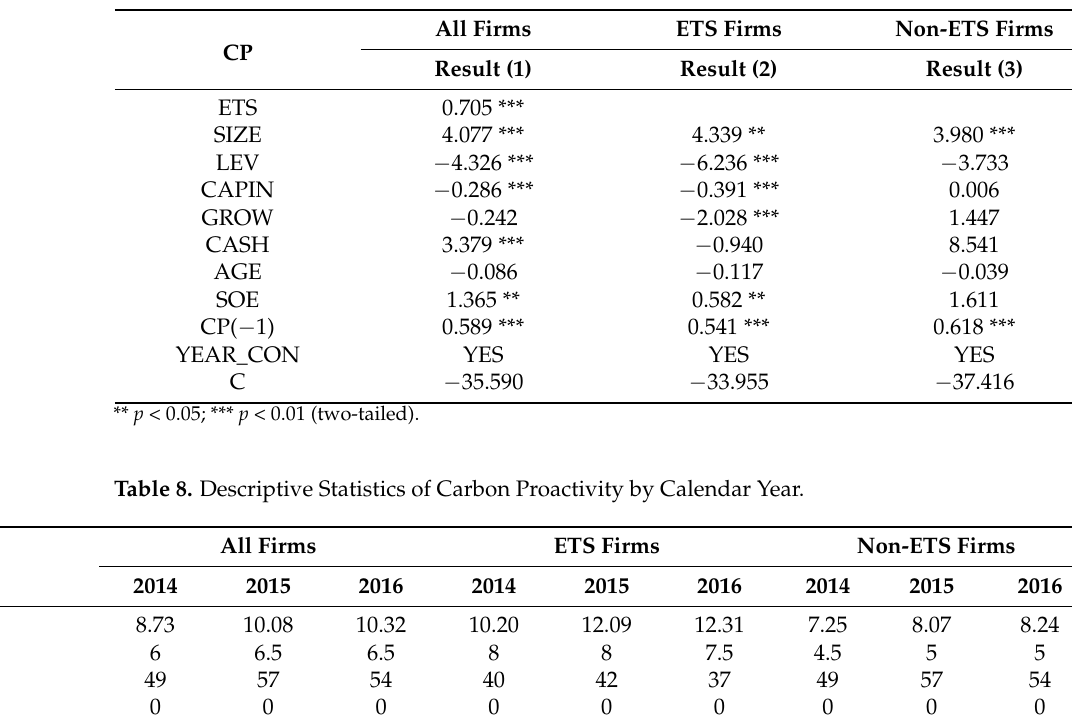
Table 7. Regression results: Equation (1).